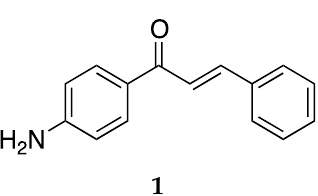
Figure 3. Chemical structure of 4-aminochalcone. Table1. Inhibitorye ff ectofcompound 1 againstthehumanMolt4 / C8; CEMT-lymphocytes; murineP388;